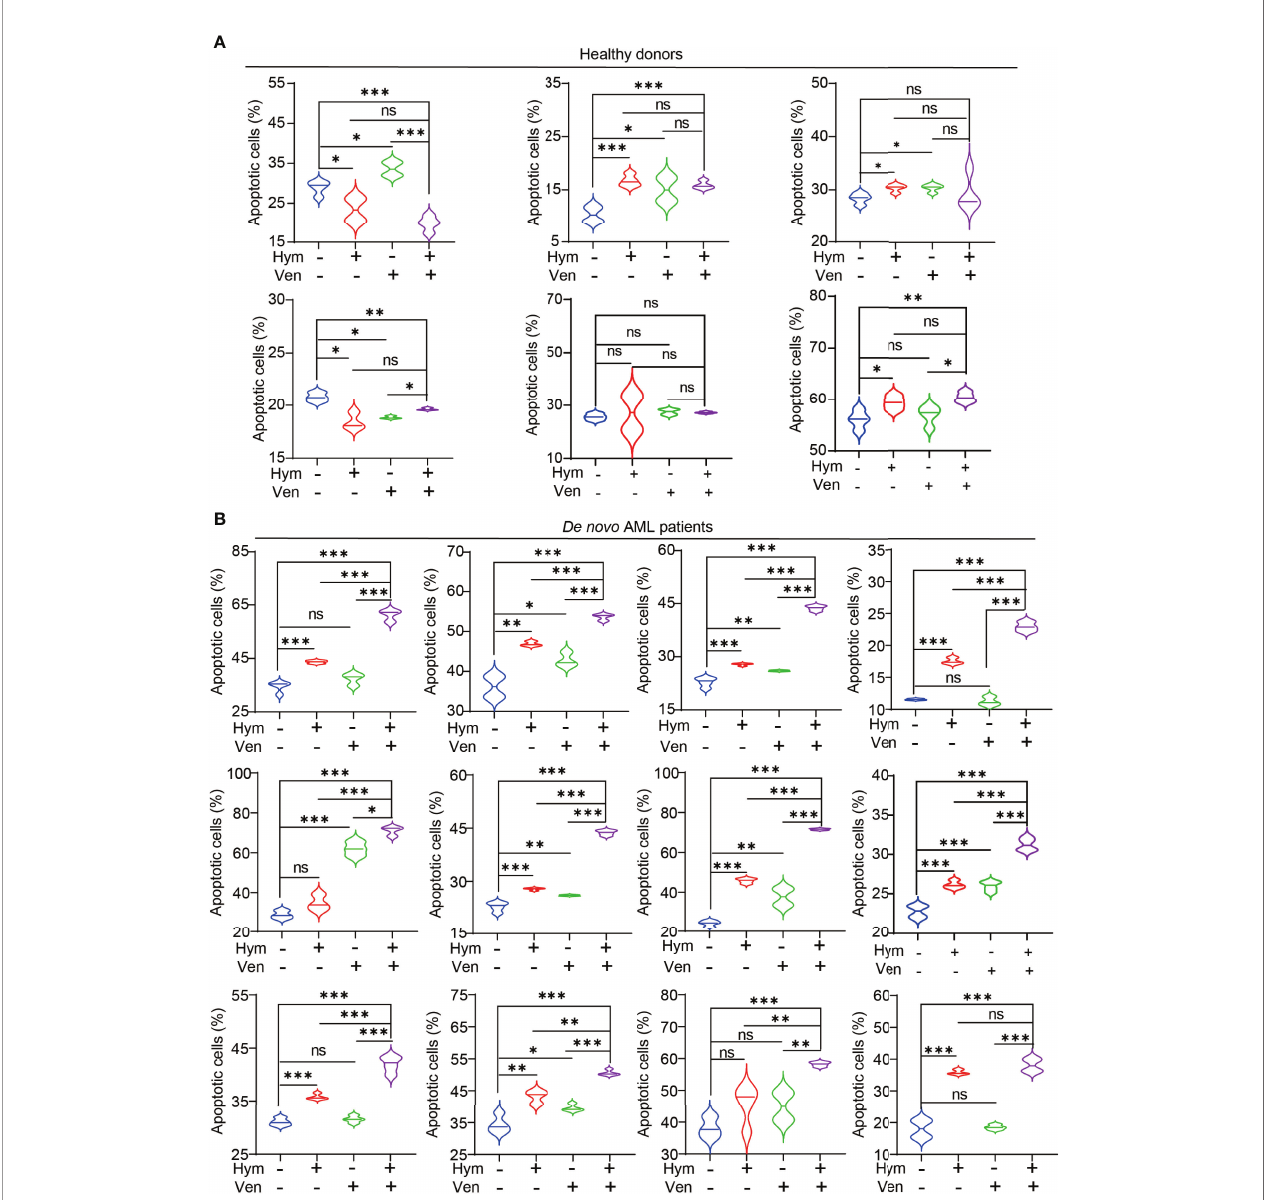
FIGURE 7 | Effects of hymeglusin and venetoclax on the apoptosis of primary cells. (A, B) The apoptotic rates after treatment of venetoclax (0.1 m M), hymeglusin (16 m M), or both for 24 hours in primary cells from healthy donors (A) or de novo patients with AML (B) *P<0.05,